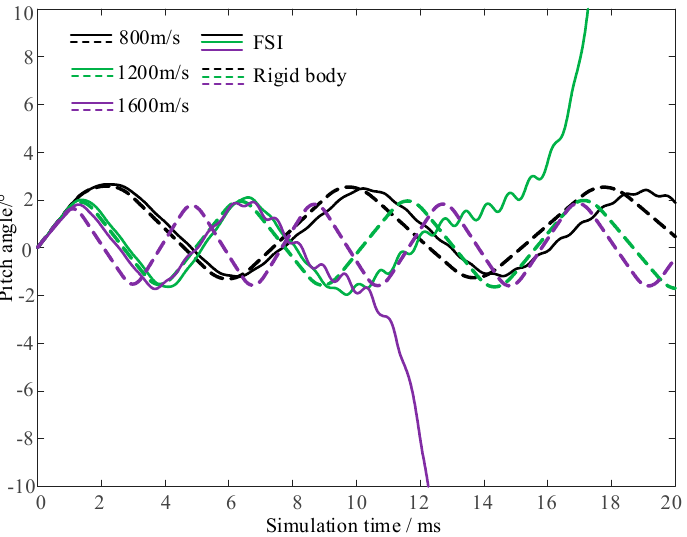
Figure 14. Changes of pitch angle of elastic and rigid supercavitating projectiles during tail-slap motion.